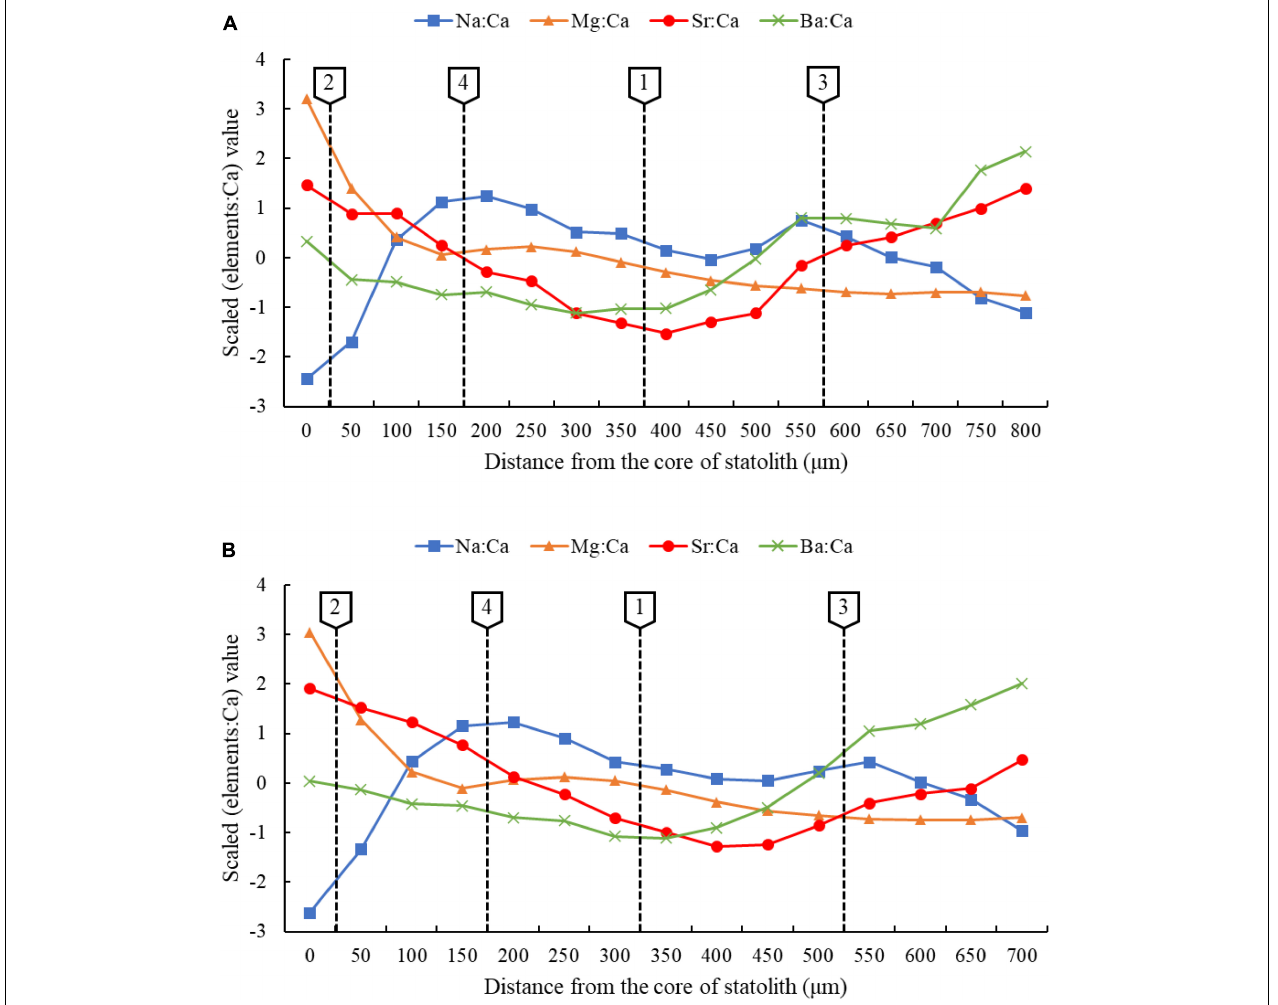
FIGURE 6 | Changing of statolith trace elements to Ca for autumn cohort (A) and winter-spring cohort (B) of Ommastrephes bartramii at different stages. TABLE 4 | The summary of distance from the core, ontogenetic stage, and elemental ratios ( µ mol/mol) for each cluster of different cohorts. Cohort Cluster Distance from the Ontogenetic stage Na:Ca number core ( µ m)